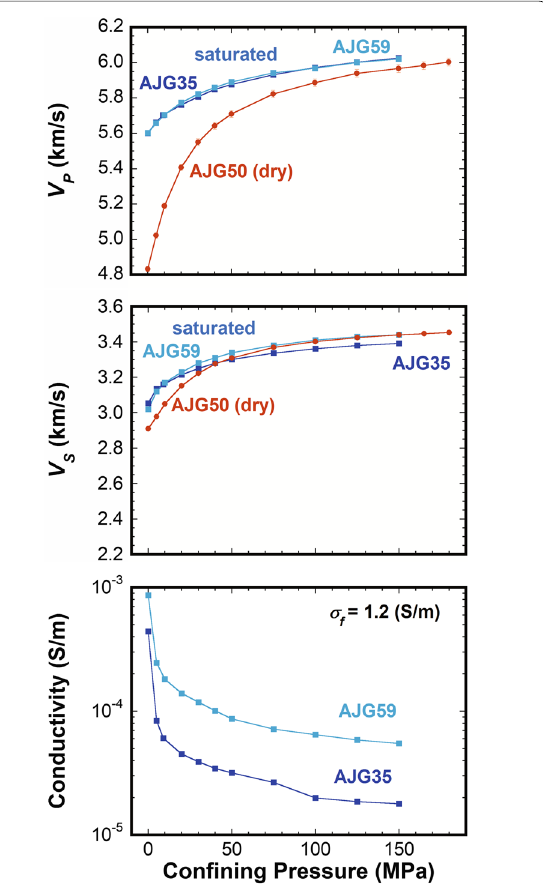
Fig. 4 Velocities and electrical conductivity in brine-saturated samples are shown as a function of confining pressure. The pore-fluid pressure was kept at atmospheric pressure (0.1 MPa). For comparison, average velocities in dry sample AJG50 are also